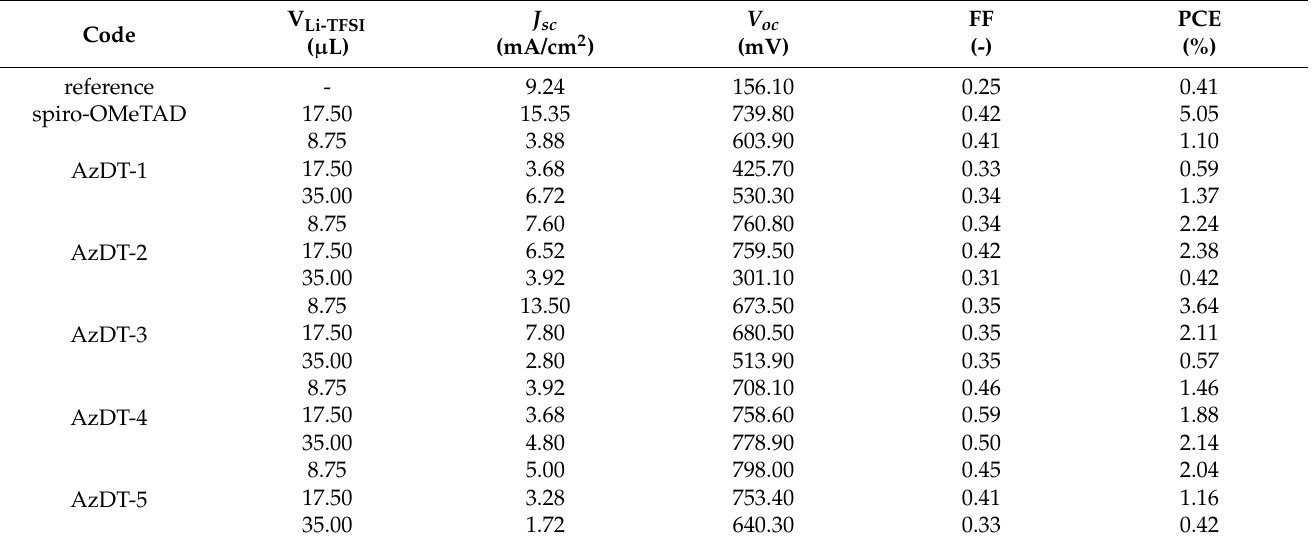
Figure 7. AFM images (20 µ m × 20 µ m) of ( a ) FTO/b-TiO 2 /m-TiO 2 /perovskite, ( b ) FTO/b-TiO 2 /m-TiO 2 /perovskite/AzDT-1, ( c ) FTO/b-TiO 2 /m-TiO 2 /perovskite/AzDT-2, ( d ) FTO/b-TiO 2 /m-TiO 2 /perovskite/AzDT-3, ( e ) FTO/b-TiO 2 /m-TiO 2 /perovskite/AzDT-4, ( f ) FTO/b-TiO 2 /m-TiO 2 /perovskite/AzDT-5 and the SEM cross-section images of ( g ) FTO/b-TiO 2 /m-TiO 2 /perovskite and ( h ) FTO/b-TiO 2 /m-TiO 2 /perovskite/AzDT-4. The photovoltaic parameters such as J sc —density of short-circuit current, V oc —open-circuit voltage, FF—fill factor, and PCE—power conversion efficiency estimated from current-voltage (I-V) characteristics are summarized in Table 4 and in Table S6 in the ESI. I-V graphs for the selected devices are collected in Figure 8. Table 4. Photovoltaic properties of the best fabricated hybrid perovskite solar cells: FTO/b-TiO 2 /m-TiO 2 /perovskite/Au, and TiO 2 /perovskite/AzDTs:V Li-TFSI /Au.